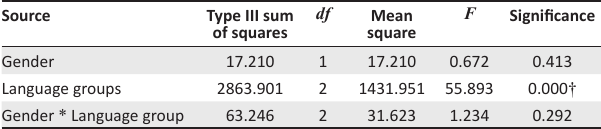
TABLE 7: ANOVA statistics for gender and language groups.